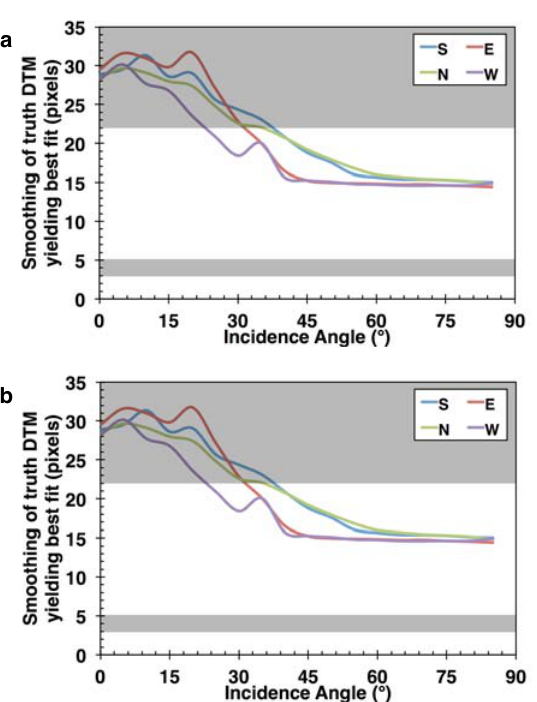
Figure 3. Variation of (a) horizontal resolution and (b) matching precision with incidence angle for stereopairs with matching illumination from the cardinal directions. Both quantities are scaled to the GSD of the high resolution shading image. Gray bands indicate the rules of thumb (resolution >3–5 pixels, ρ ~0.2–0.3 pixel). The lower band is based on the GSD of the shading images. The upper band in b is appropriate to the albedo image GSD.